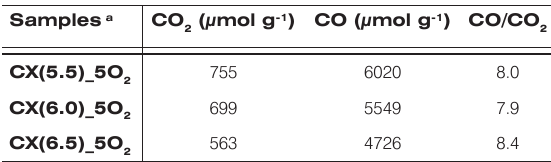
evolution; (2) CO 2